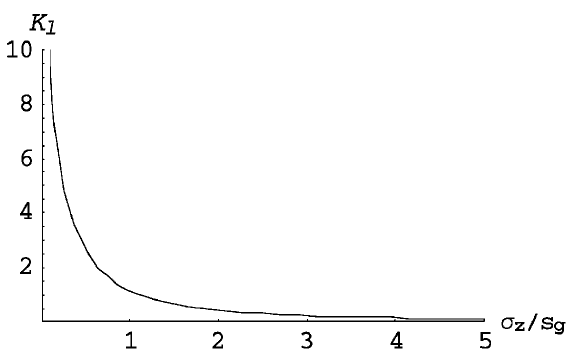
(cid:1) (cid:3) (cid:3) which determines the loss =s l s g